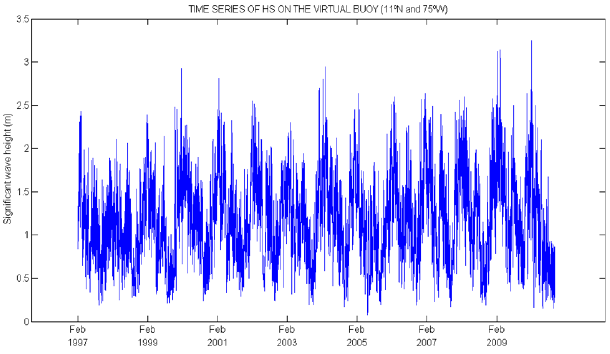
Fig. 9. Significant wave height of the virtual buoy.